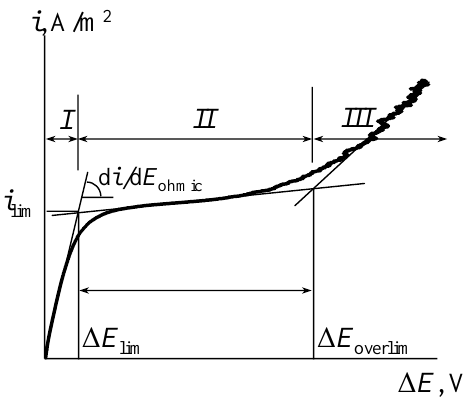
Figure 3. Typical CVC of the IEM: I: the ohmic section; II: the plateau of limiting current; III: the overlimiting region.